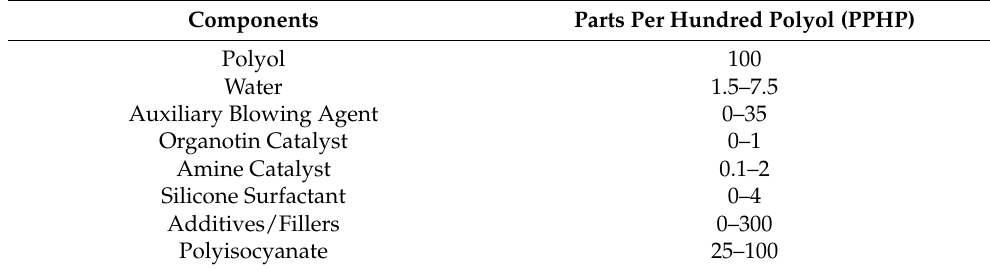
Table 1. Polyurethane formulation for flexible foams [3].